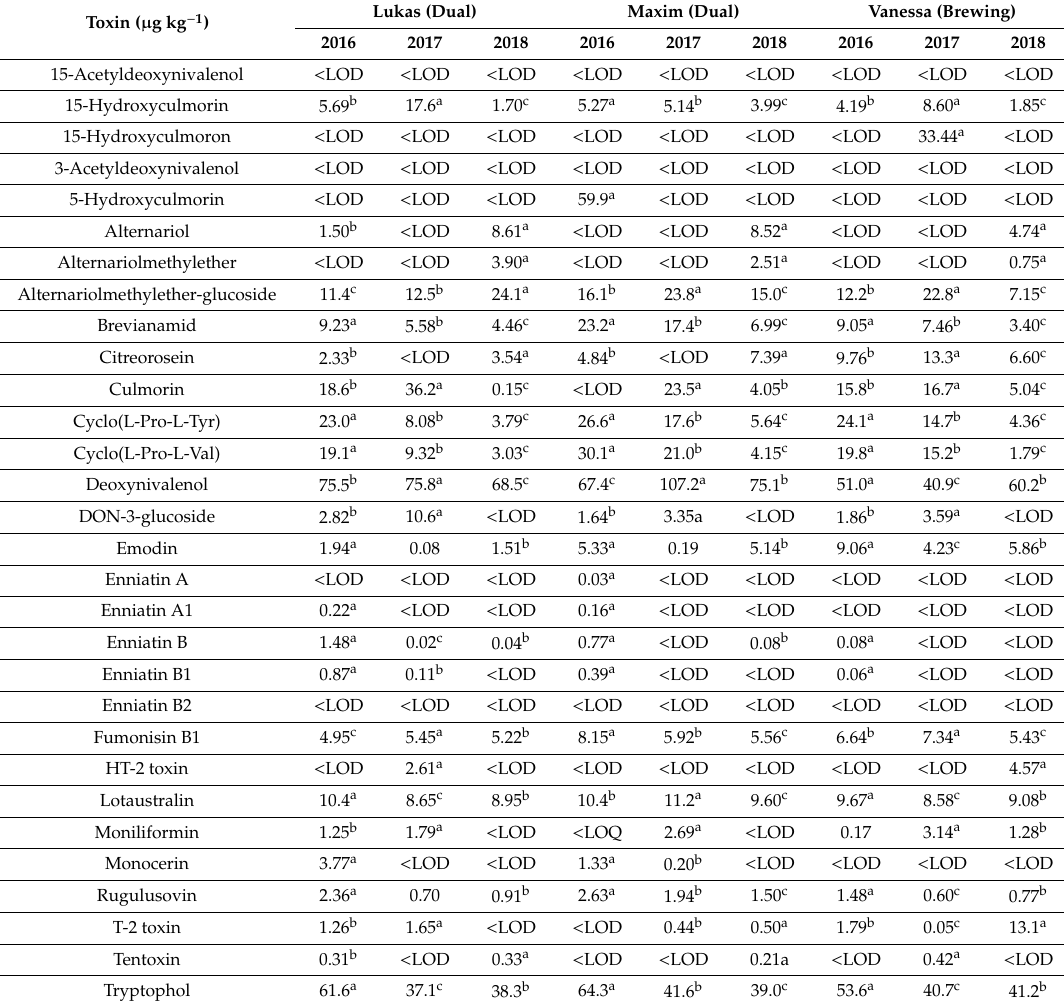
Table 4. Concentrations of other positively identified mycotoxins and fungal metabolites in barley